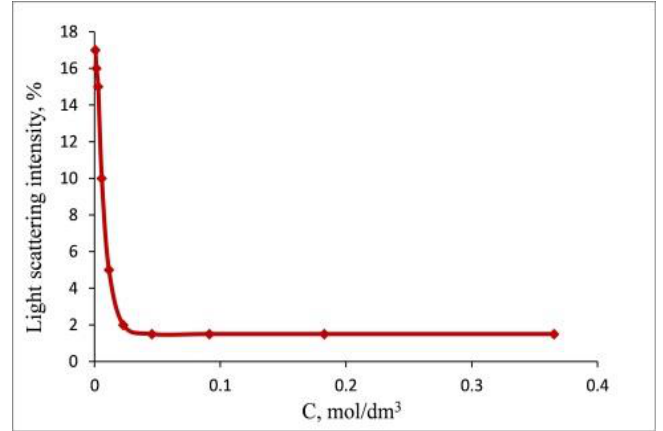
Figure 2. Dependence of the light-scattering intensity on the CAPB concentration in the solution of suspensions of the strain Pseudomonas pseudoalcaligenes (B-6783) VSB-10. As shown in Table 1, the minimum inhibitory concentration of CAPB for all tested strains is 45.6 mmol/dm 3 . Table 1. Inhibition of microbial growth in the presence of CAPB 1 .